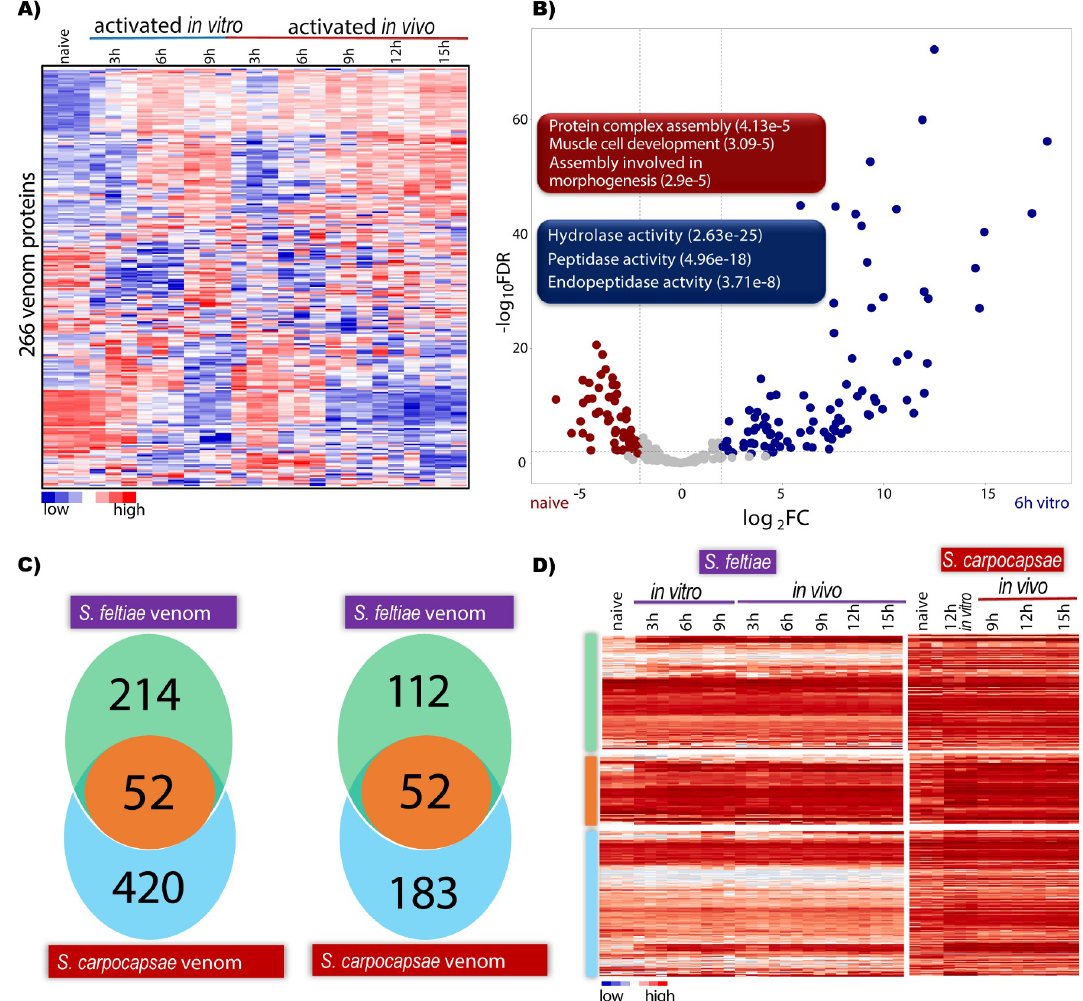
Fig 5. Gene expression of S . feltiae venom proteins in vitro and in vivo and comparison with S . carpocapsae . (A) Heatmap of the expression levels of 266 venom protein genes in both in vitro and in vivo activated IJs. (B) Volcano plot of 266 venom proteins showing the differentially expressed genes in non-activated and 6 hours in vitro activated IJs. Red and blue boxes are representative GO terms for significantly differentially expressed venom proteins. (C) Venn diagram illustrating the comparison of all S . carpocapsae venom proteins with S . feltiae venom proteins. (D) Venn diagram of conserved venom proteins with homologs in both species. 52 conserved proteins were detected in the venom of both species. (E) Heatmap of expression of the conserved homologs in panel D.